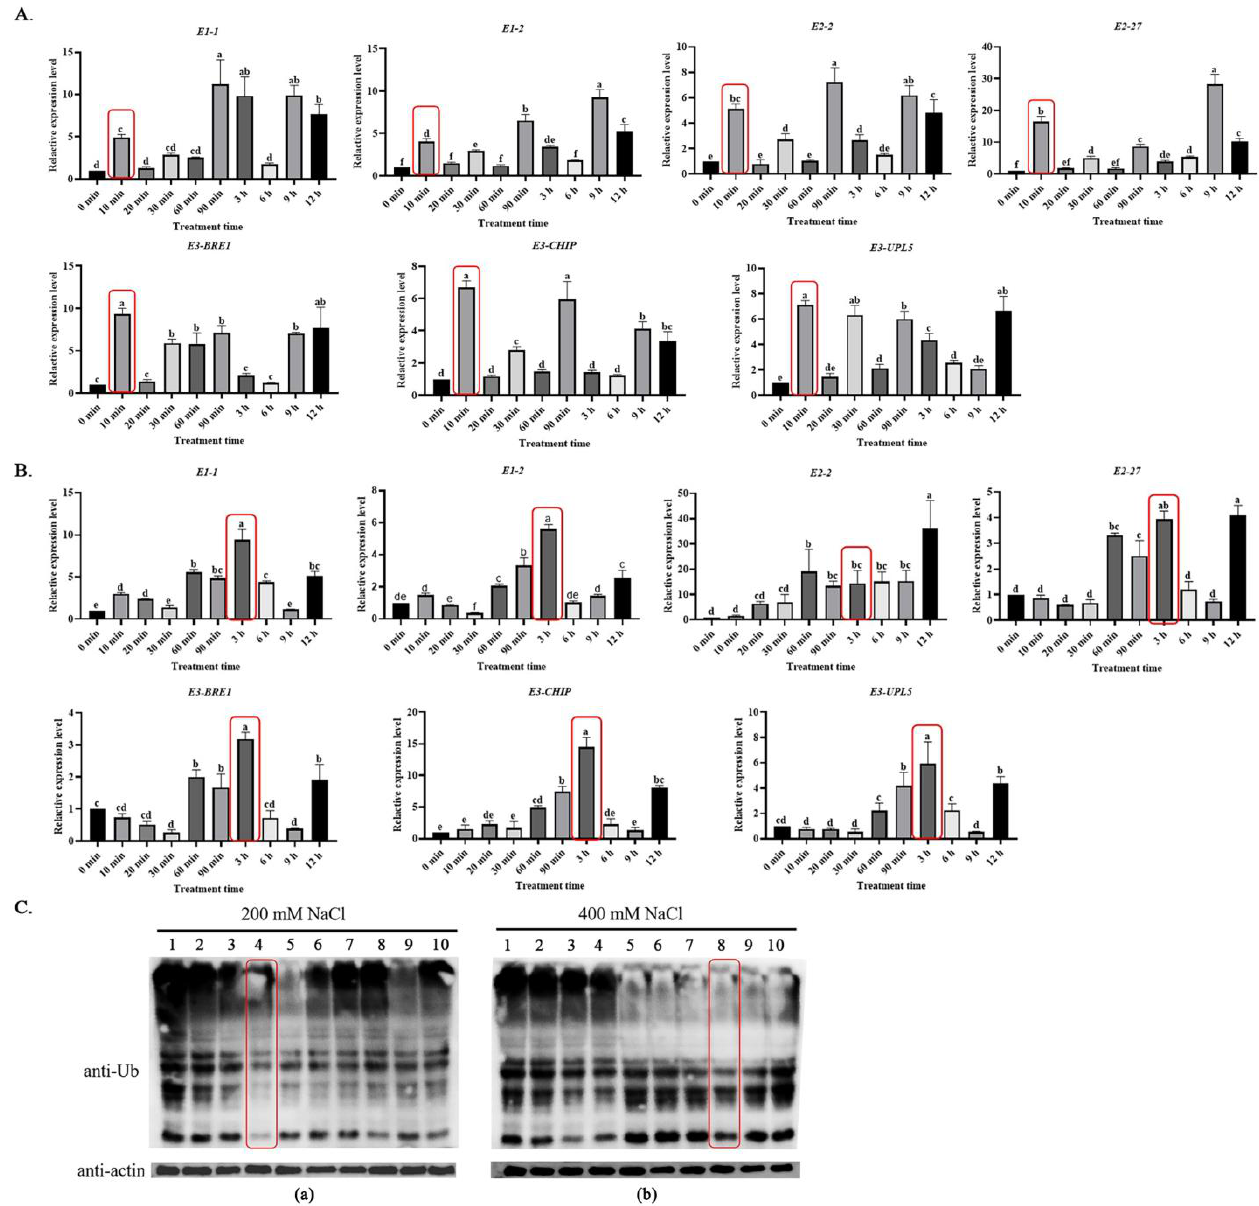
Figure 1. Gene transcription and protein level responses of the ubiquitin system in the roots of sugar beet M14 after salt stress treatments. ( A ) qRT-PCR of key genes in the ubiquitin system after 200 mM NaCl treatment. ( B ) qRT-PCR of key genes in the ubiquitin system after 400 mM NaCl treatment. The red-rectangle-enclosed bars represent the initial response time of key enzyme genes in the ubiquitin system to salt stress. Data were analyzed by Duncan’s analysis of variance, and different lowercase letters (a, b, c, d, e, f) indicate differences in genes expression. ( C ) Western blot analysis of protein ubiquitination levels after ( a ) 200 mM NaCl and ( b ) 400 mM NaCl treatments. The red-rectangle-enclosed lanes represent the point in time when the overall ubiquitination protein was significantly reduced. Lanes 1–10 represent the samples after different times of NaCl treatment, respectively: 1, 0 min; 2, 10 min; 3, 20 min; 4, 30 min; 5, 60 min; 6, 90 min; 7, 3 h; 8, 6 h; 9, 9 h; 10, 12 h. Different letters above bars denote statistical